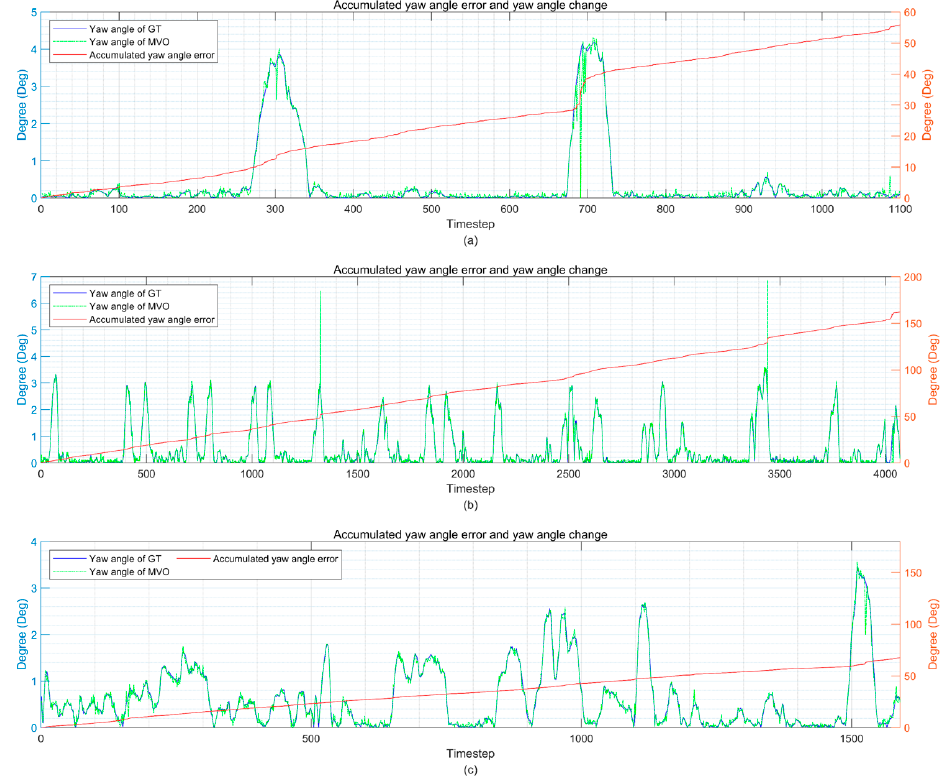
Figure 4. Accumulated yaw angle error and yaw angles of ground truth (GT) and camera calculated by Monocular Visual Odometry (MVO) with KITTI 06, 08, and 09 sequences. ( a ) The KITTI sequence 06. ( b ) The KITTI sequence 08. ( c ) The KITTI sequence 09. The left y-axis is for the yaw angle and the right y-axis is for the accumulated yaw angle error.